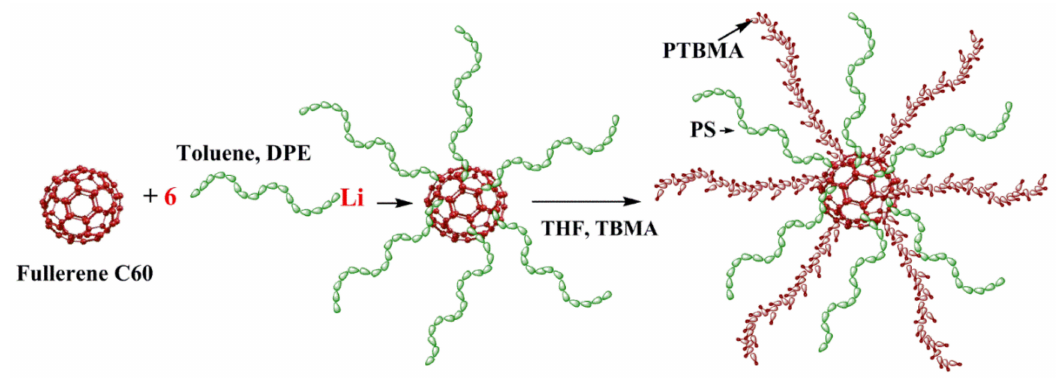
Figure 1. The synthesis of heteroarm stars (HAS), where DPE is 1,1-diphenylethylene, THF is tetrahydrofurane, and TBMA is